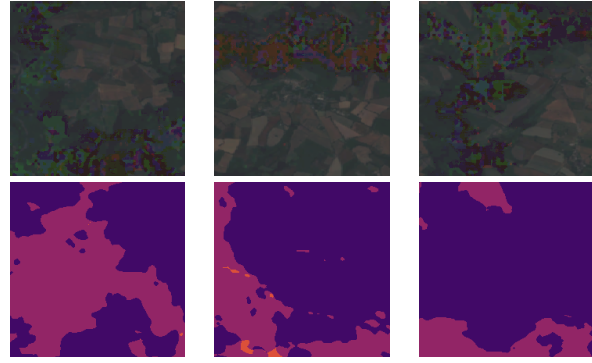
Figure 5. Failure cases (top row) and corresponidng cloud coverage (bottom